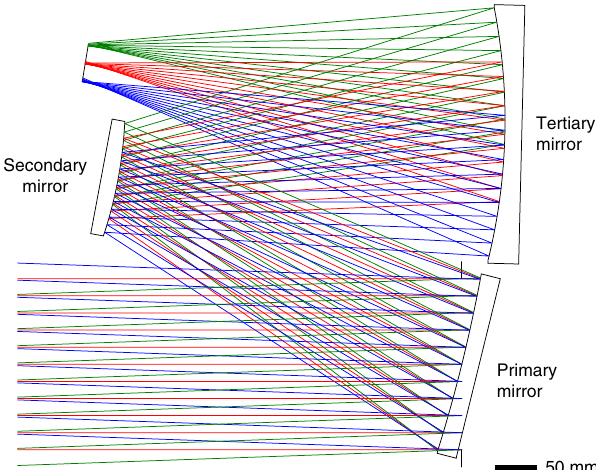
Fig. 2 The starting design. The design with the greatest potential to be corrected using freeform surfaces was found to be Fig. 1a. The powers of the surfaces were then modi fi ed to fl atten the fi eld while holding the focal length. In its current form it consists of all spherical